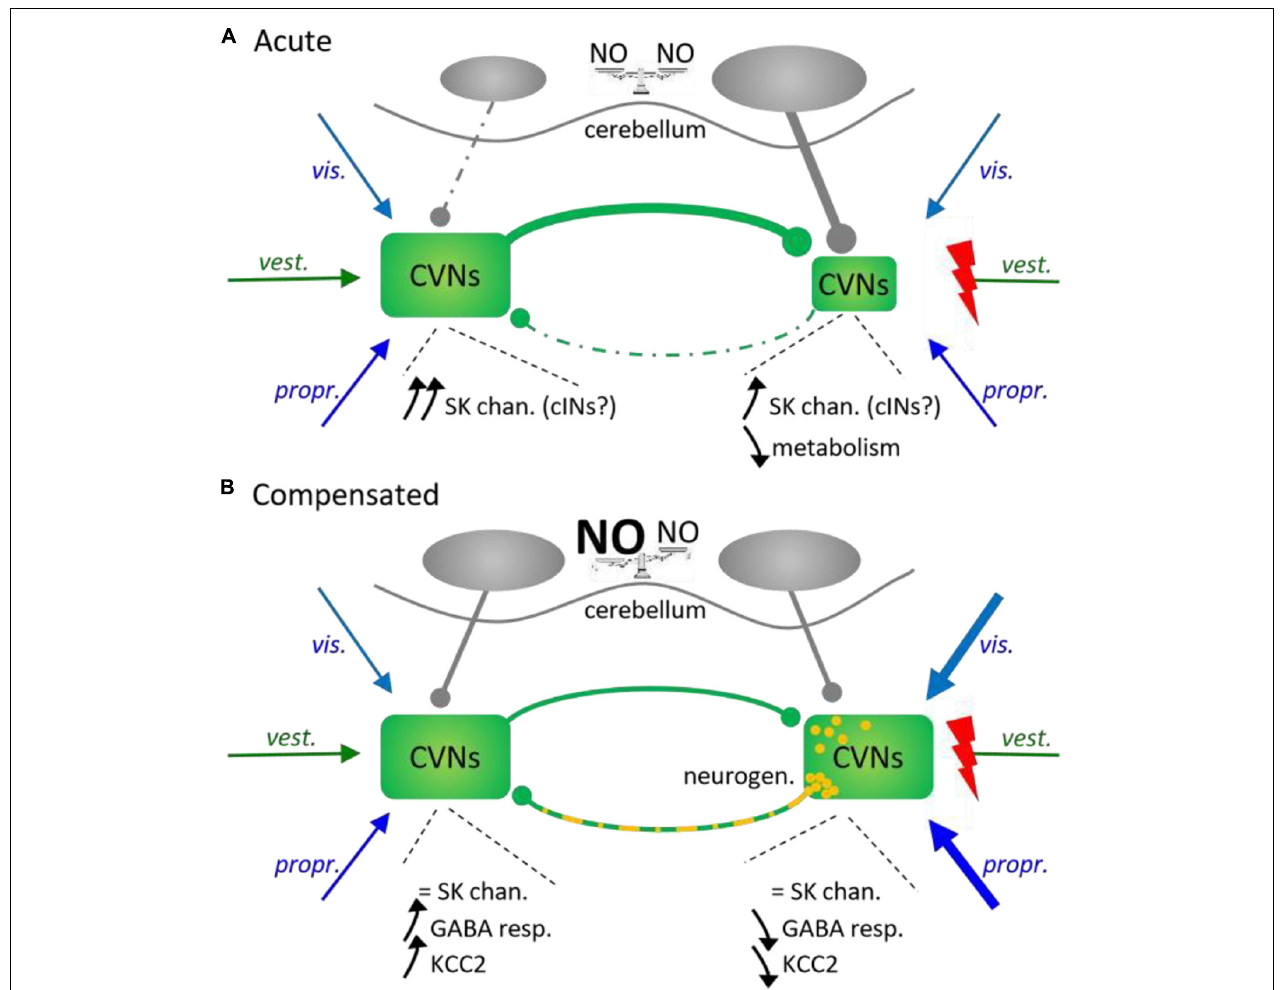
FIGURE 4 | Unilateral vestibular deprivation-induced adaptations in central vestibular nuclei and cerebellum. (A) Acute effects. A unilateral loss of vestibular afferents ( vest. ) triggers a rapid decrease in ipsilesional CVN neurons activity due to conjoint intrinsic and metabolic modifications together with increased inhibition from contralateral central vestibular nuclei (CVNs) and ipsilateral cerebellar nuclei. Although intrinsic properties of CVN neurons change bilaterally, net effect consists of a disequilibrium in reciprocal inhibition through commissural vestibular pathways (cINs) resulting in a stronger inhibition of ipsilesional CVNs. vis. , propr. , visual and proprioceptive afferents; NO, nitric oxide. Dotted lines: underactivated influences. (B) Compensated cerebello-vestibular network. Restoration of bilateral balance results from additional changes in intrinsic and synaptic properties of CVN neurons on both sides, together with ipsilesional GABAergic neurogenesis (yellow dots) and increased synaptic weight of both visual and proprioceptive inputs onto ipsilesional CVNs. Bilateral balance restoration also occurs in cerebellar nuclei due to a relative increase in NO on the contralesional